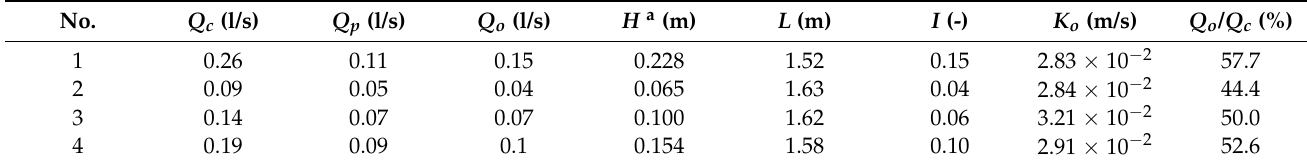
Table 5. Scenario B on a laboratory model of an extraction well.